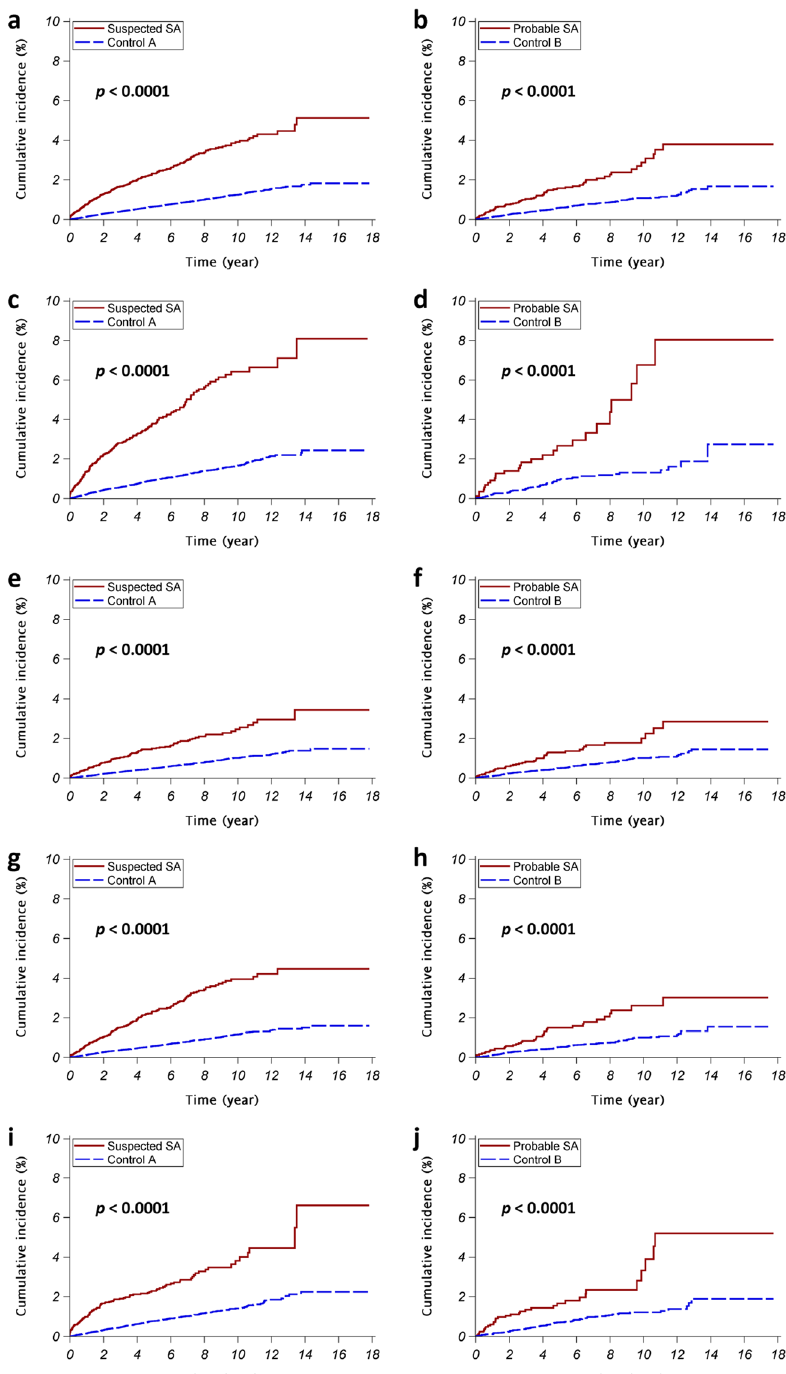
Figure 2. The cumulative incidences of major depressive disorder (MDD). The red continuous lines and blue dashed lines show the cumulative incidence of MDD for the sleep apnea patients and the control subjects, respectively. ( a , c , e , g , i ) suspected sleep apnea patients vs. control A subjects; ( b , d , f , h , j ) probable sleep apnea patients vs. control B subjects; ( a , b ) all eligible subjects; ( c , d ) female subjects; ( e , f ) male subjects; ( g , h ) subjects ≤ 50 years old; ( i , j ) subjects > 50 years